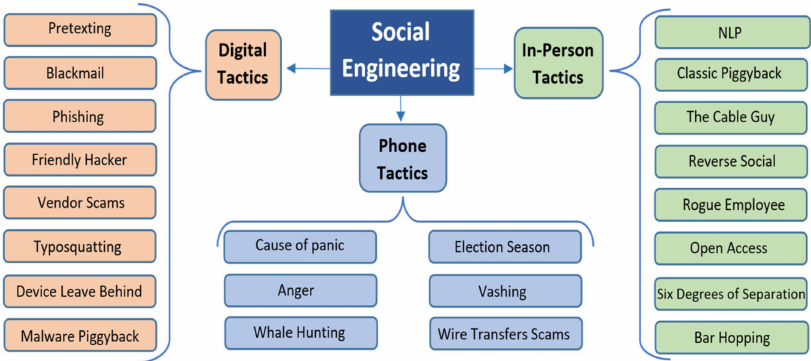
Figure 9. Classification of Social Engineering attacks.